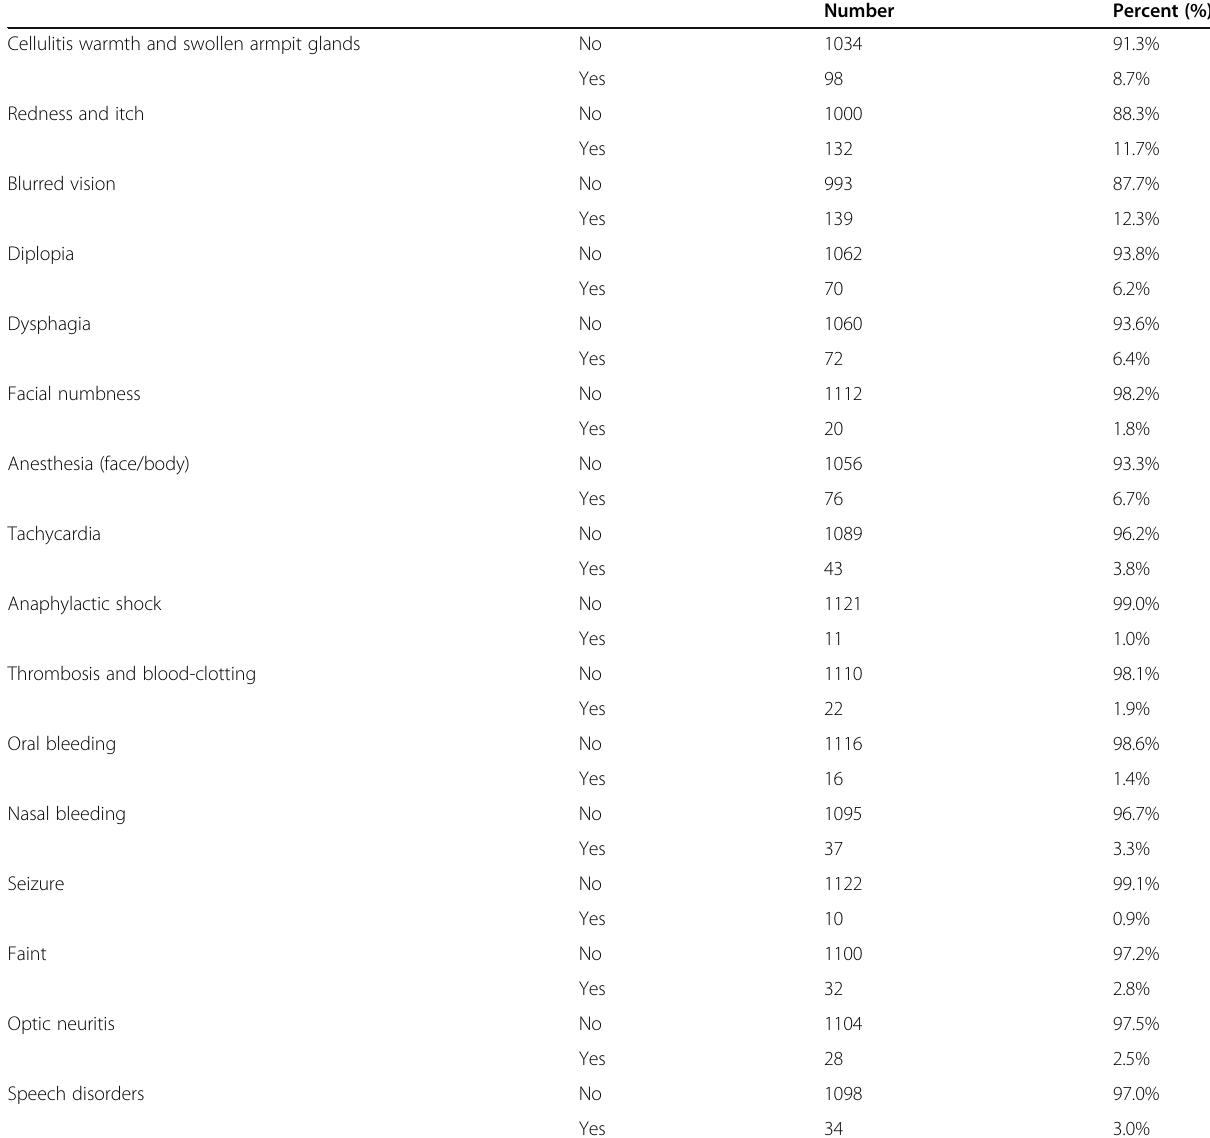
Table 2 Frequency of side effects in total (Continued)